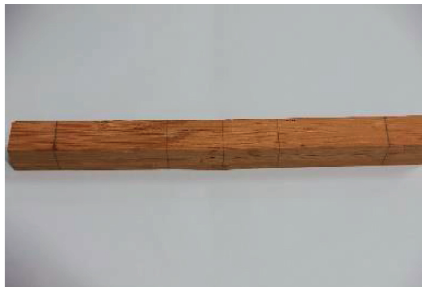
Figure 4: Failure mode of bending specimen.